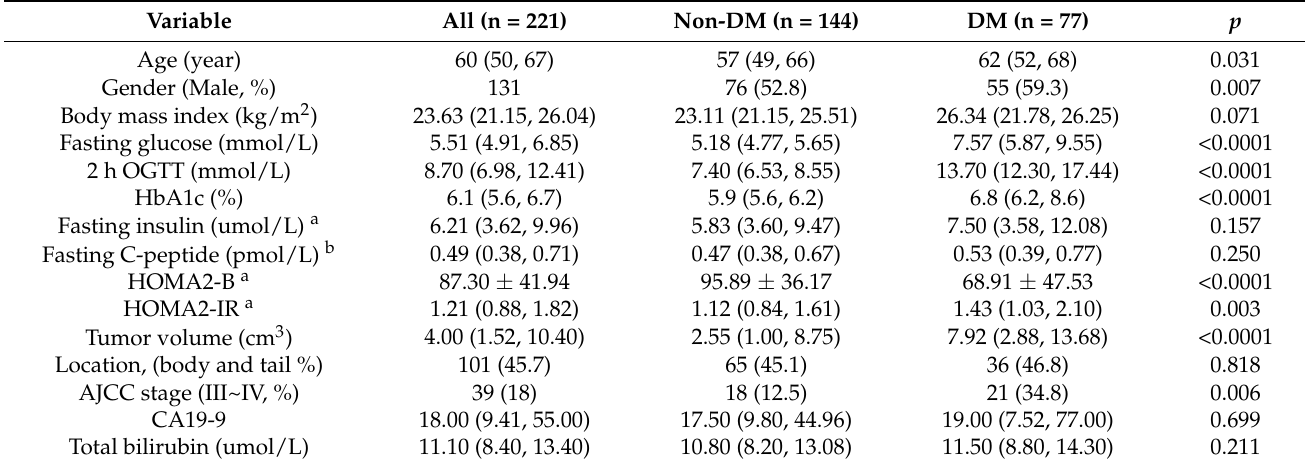
Table 1. Patient characteristics according to diabetes mellitus (DM)